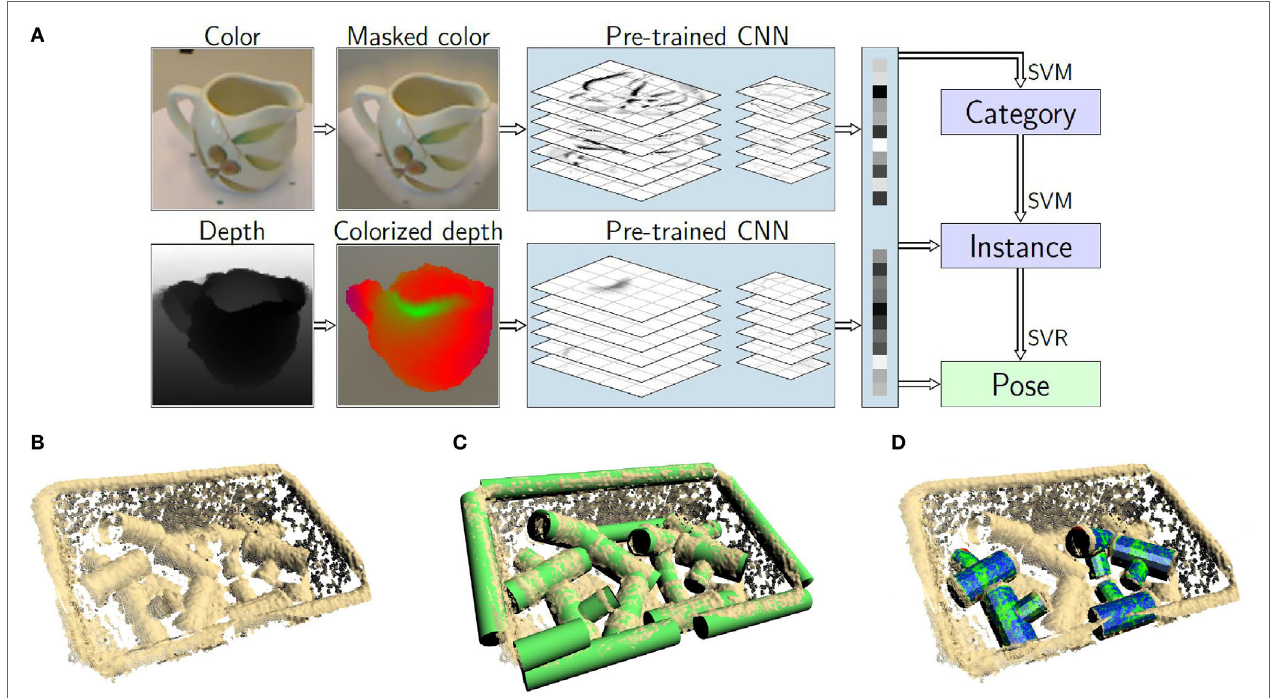
FIgURe 7 | object perception . (A) Object categorization, instance recognition, and pose estimation based on features extracted by a pretrained convolutional neural network (Schwarz et al., 2015b). Depth is converted to a color image by rendering a canonical view and encoding distance from the object vertical axis; object detection based on geometric primitives. (B) Point cloud captured by Cosero’s Kinect camera. (c) Detected cylinders. (D) Detected objects (Nieuwenhuisen et al.,